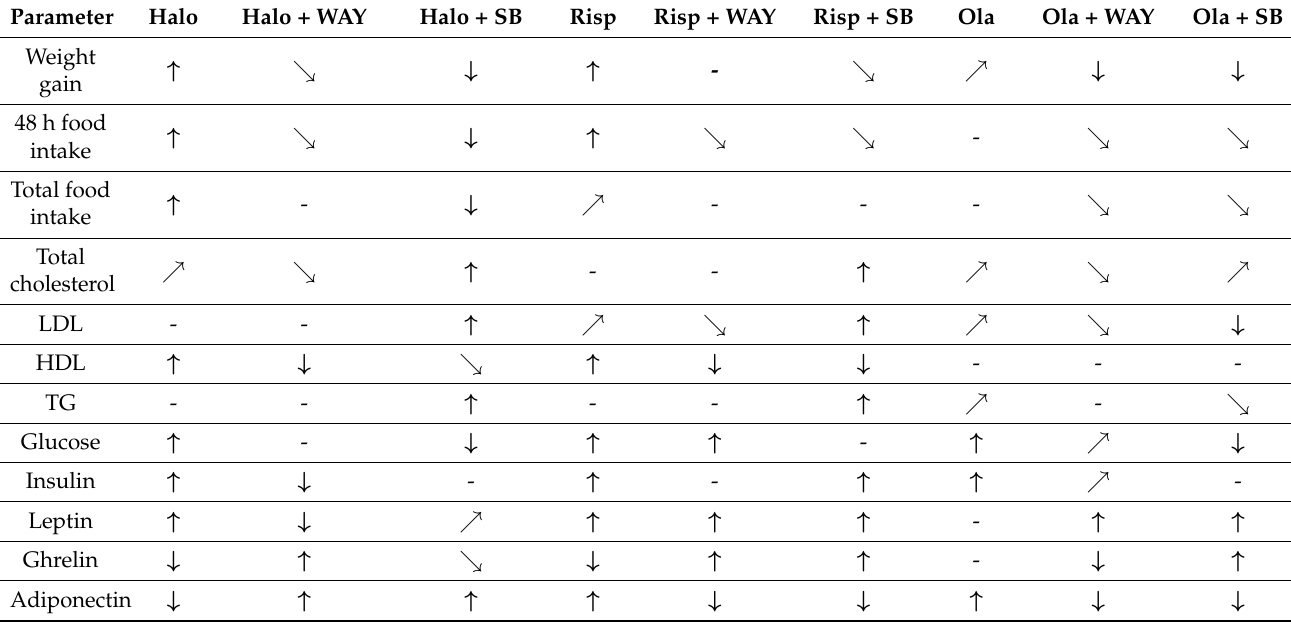
Table 1. Effects of separate and combined administration of tested APDs and 5-HT 6 receptor ligands on measured